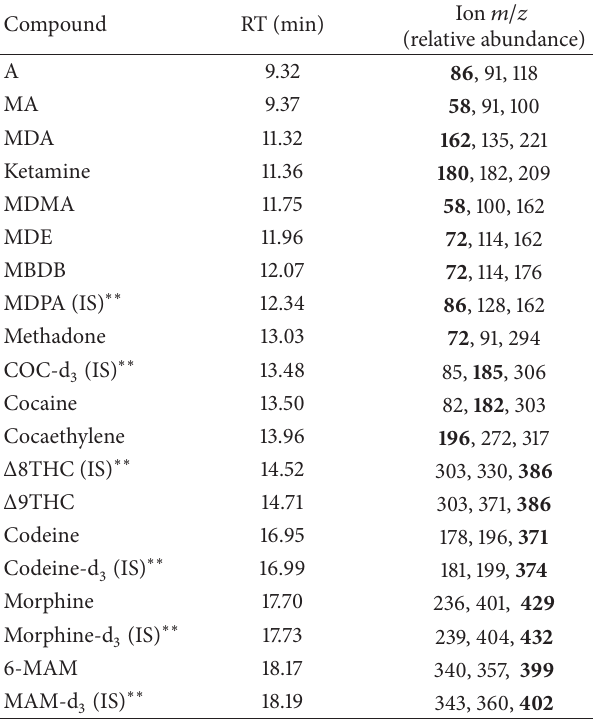
Table 1: Monitored ions and retention time (RT) for drugs of abuse in oral fluid samples by